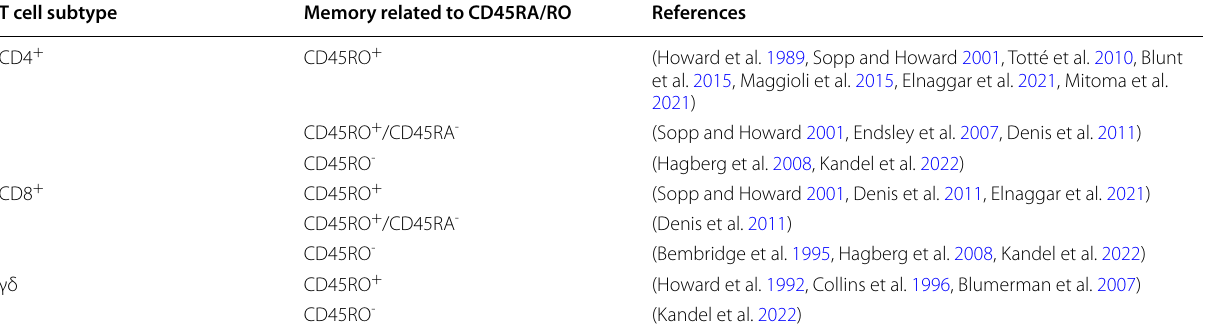
Table 2 CD45RO expression on the bovine memory T cells T cell subtype Memory related to